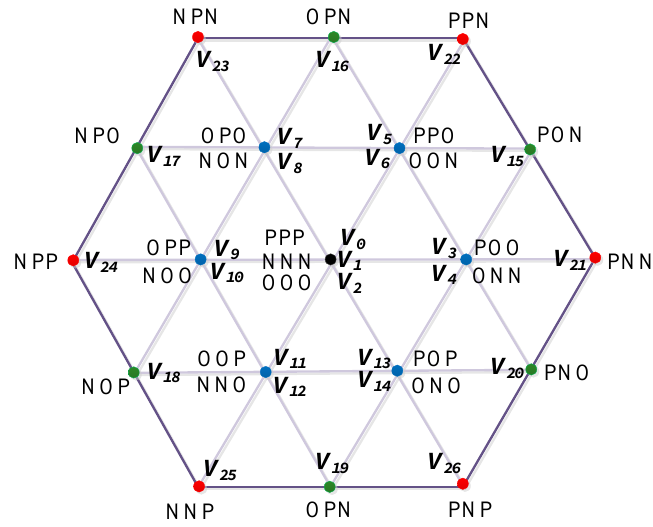
Figure 2. Voltage space-vector diagram of a three-level inverter. Table 1. Switching states of 3L-NPC Inverter.